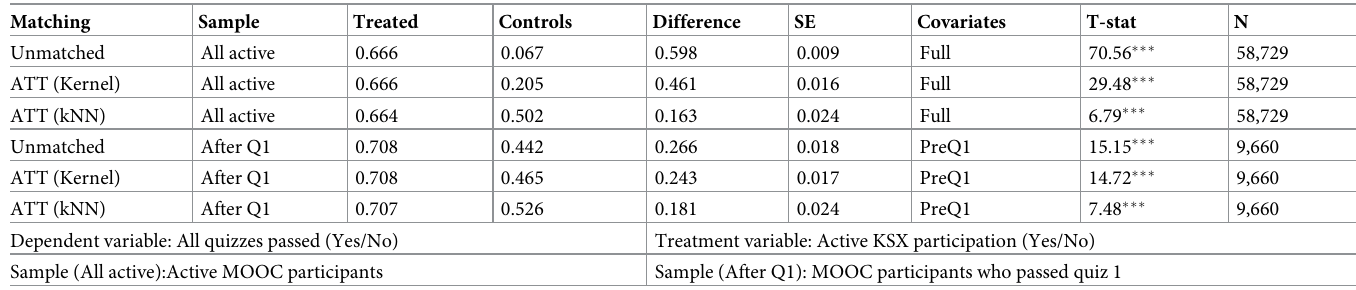
Table 5. Effect of KSX participation on MOOC completion rate.